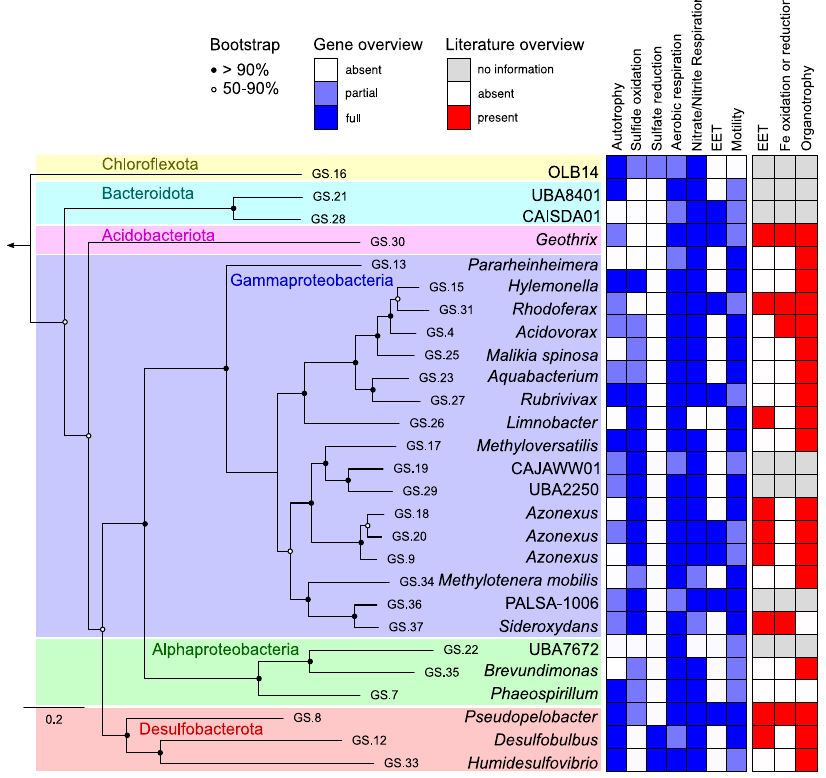
Fig. 3 | Genome-based phylogeny and selected key features of putative cable bacteria-associated bacteria. Data were derived from the annotation of metagenome- assembled genomes and from literature searches. EET, extracellular electron transfer. Source data are provided in Supplementary Datasets 1 –